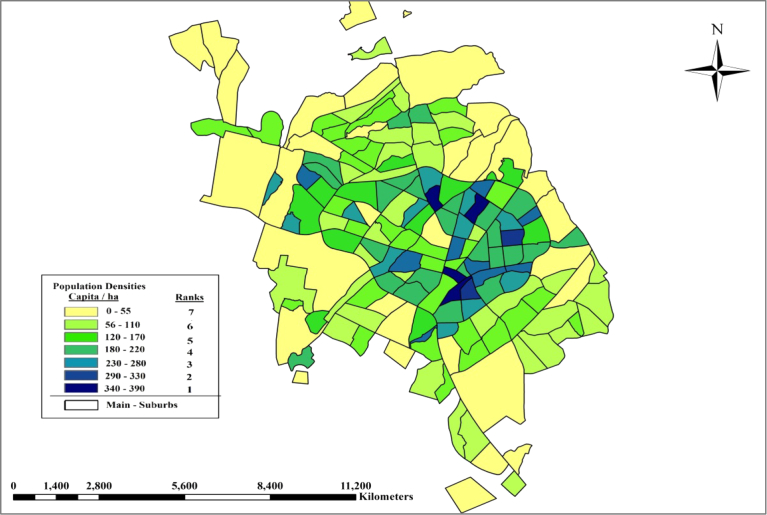
Classification of the Population Density of Sulaimania City at each Suburbs.